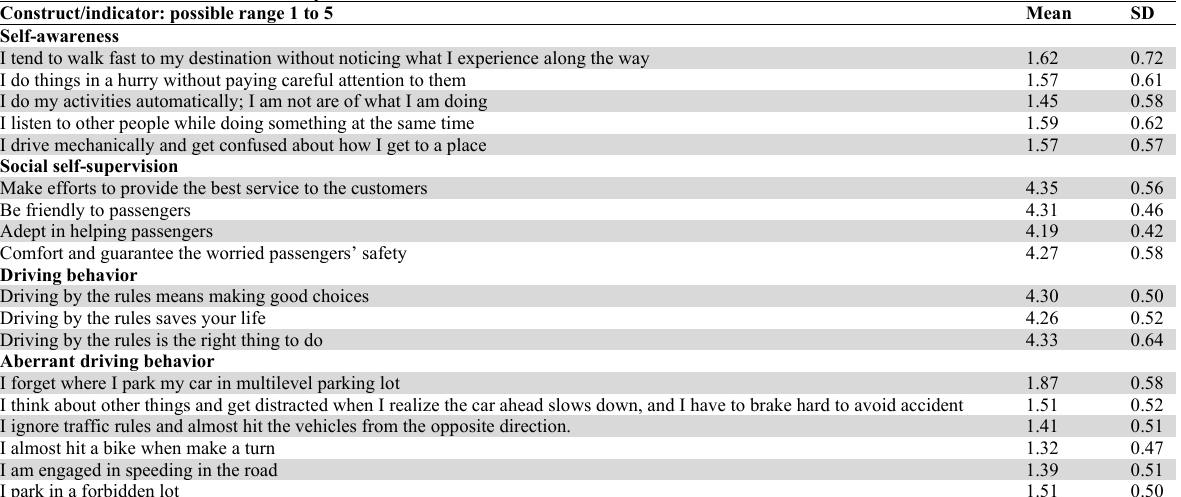
Detailed information of the survey items Construct/indicator: possible range 1 to 5